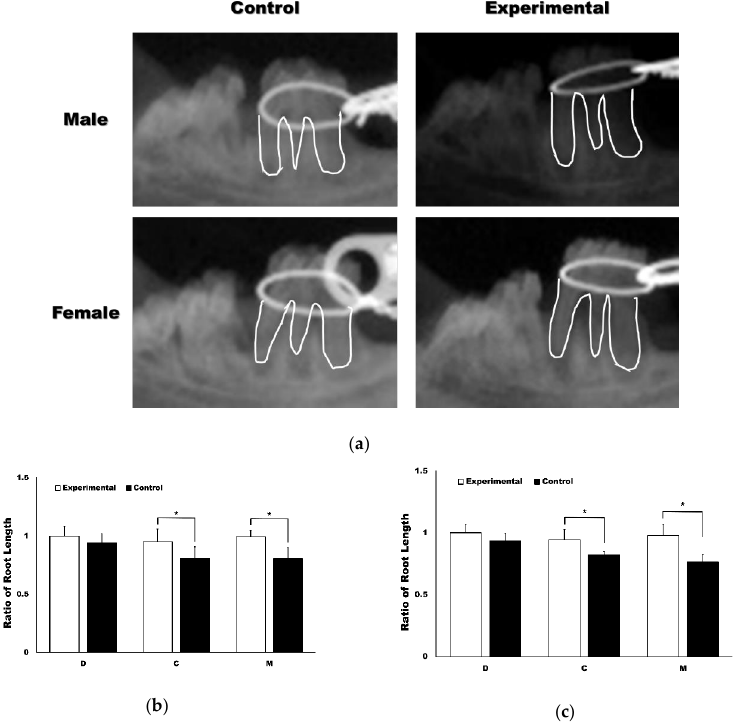
Figure 2. The ratio of root length. The ratio was calculated between the root lengths of the moved tooth and those of the opposite arch. ( a ) Traced outline of roots. The ratio of root length was calculated by comparison with the mandibular first molar in the opposite arch. ( b ) The root length comparison in the male group. There was no significant difference in the length of the distal root (D) ( p > 0.05). However, there was a significant difference in the central roots (C) and the mesial root (M) (* p < 0.05). ( c ) The root length comparison in the female group. The trend was in accordance with the male group comparison (* p < 0.05).